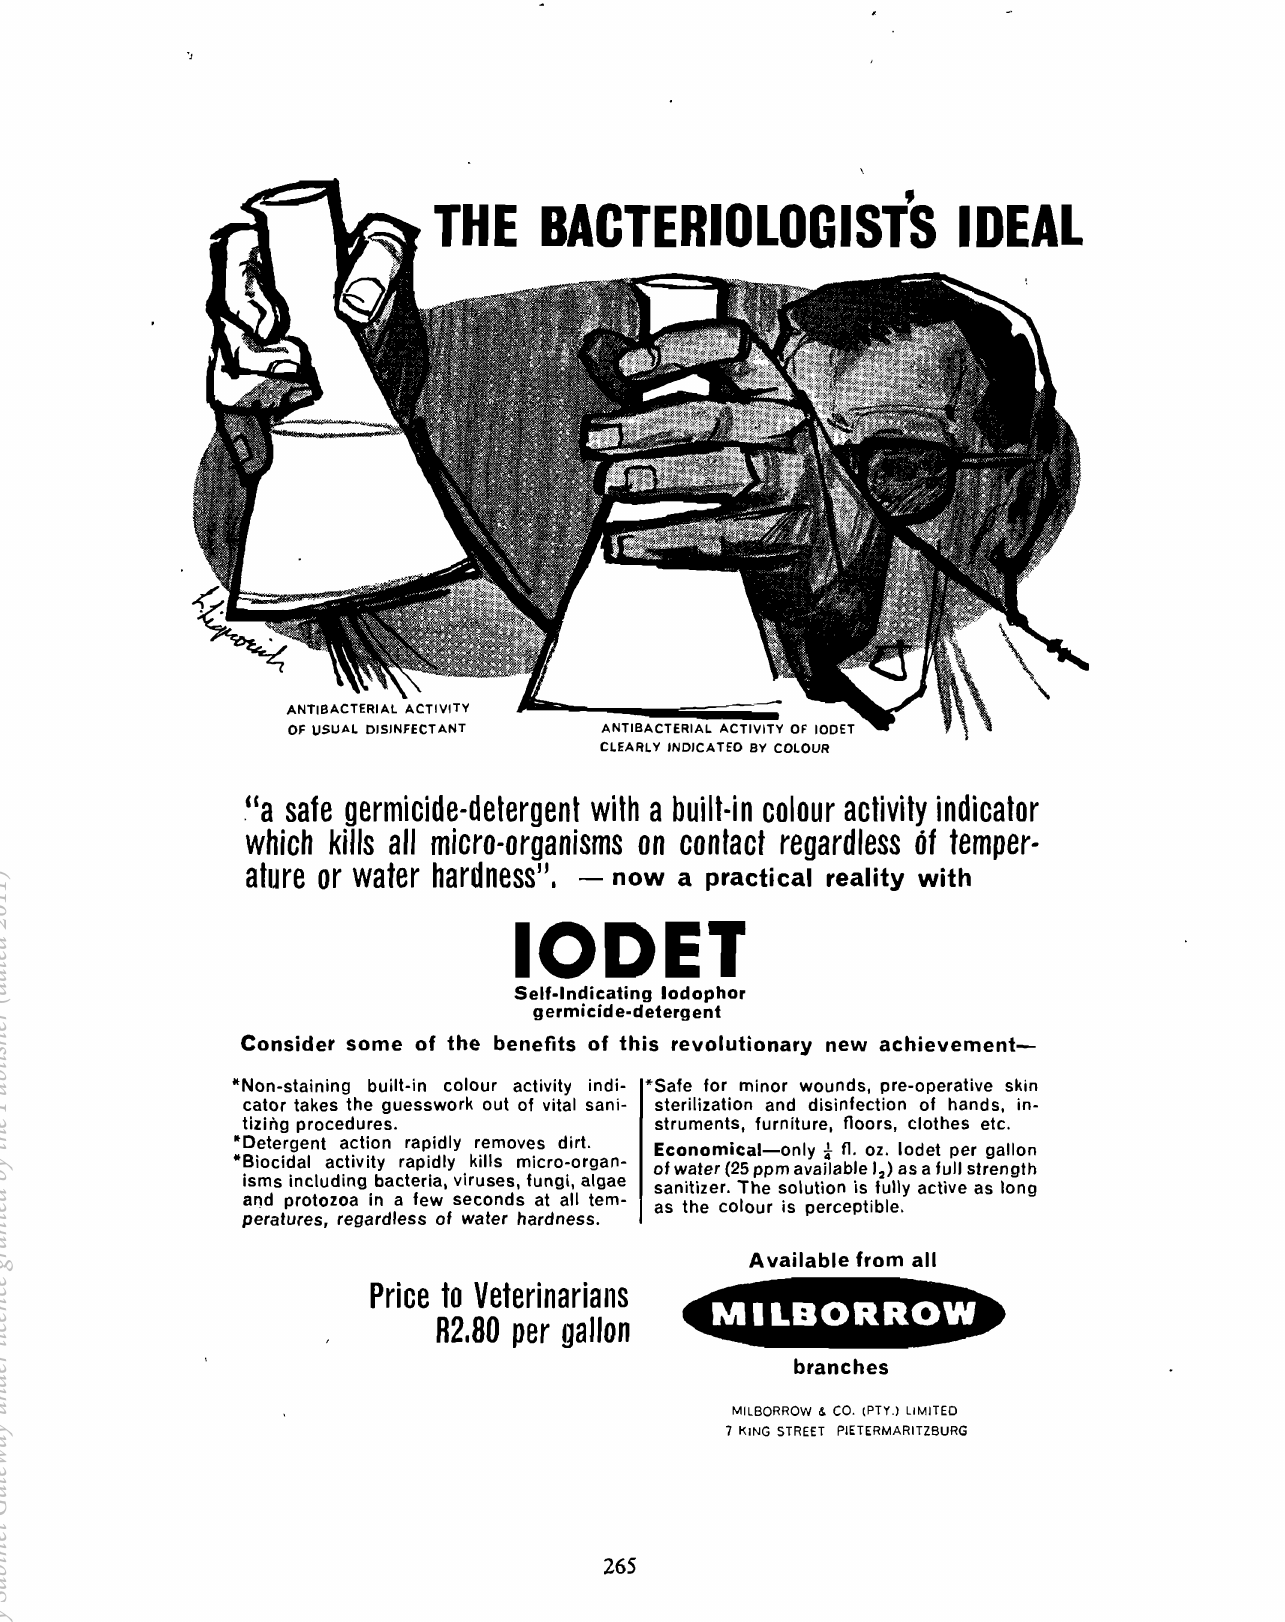
*Safe for minor wounds, pre-operative skin sterilization and disinfection of hands, in struments, furniture, floors, clothes